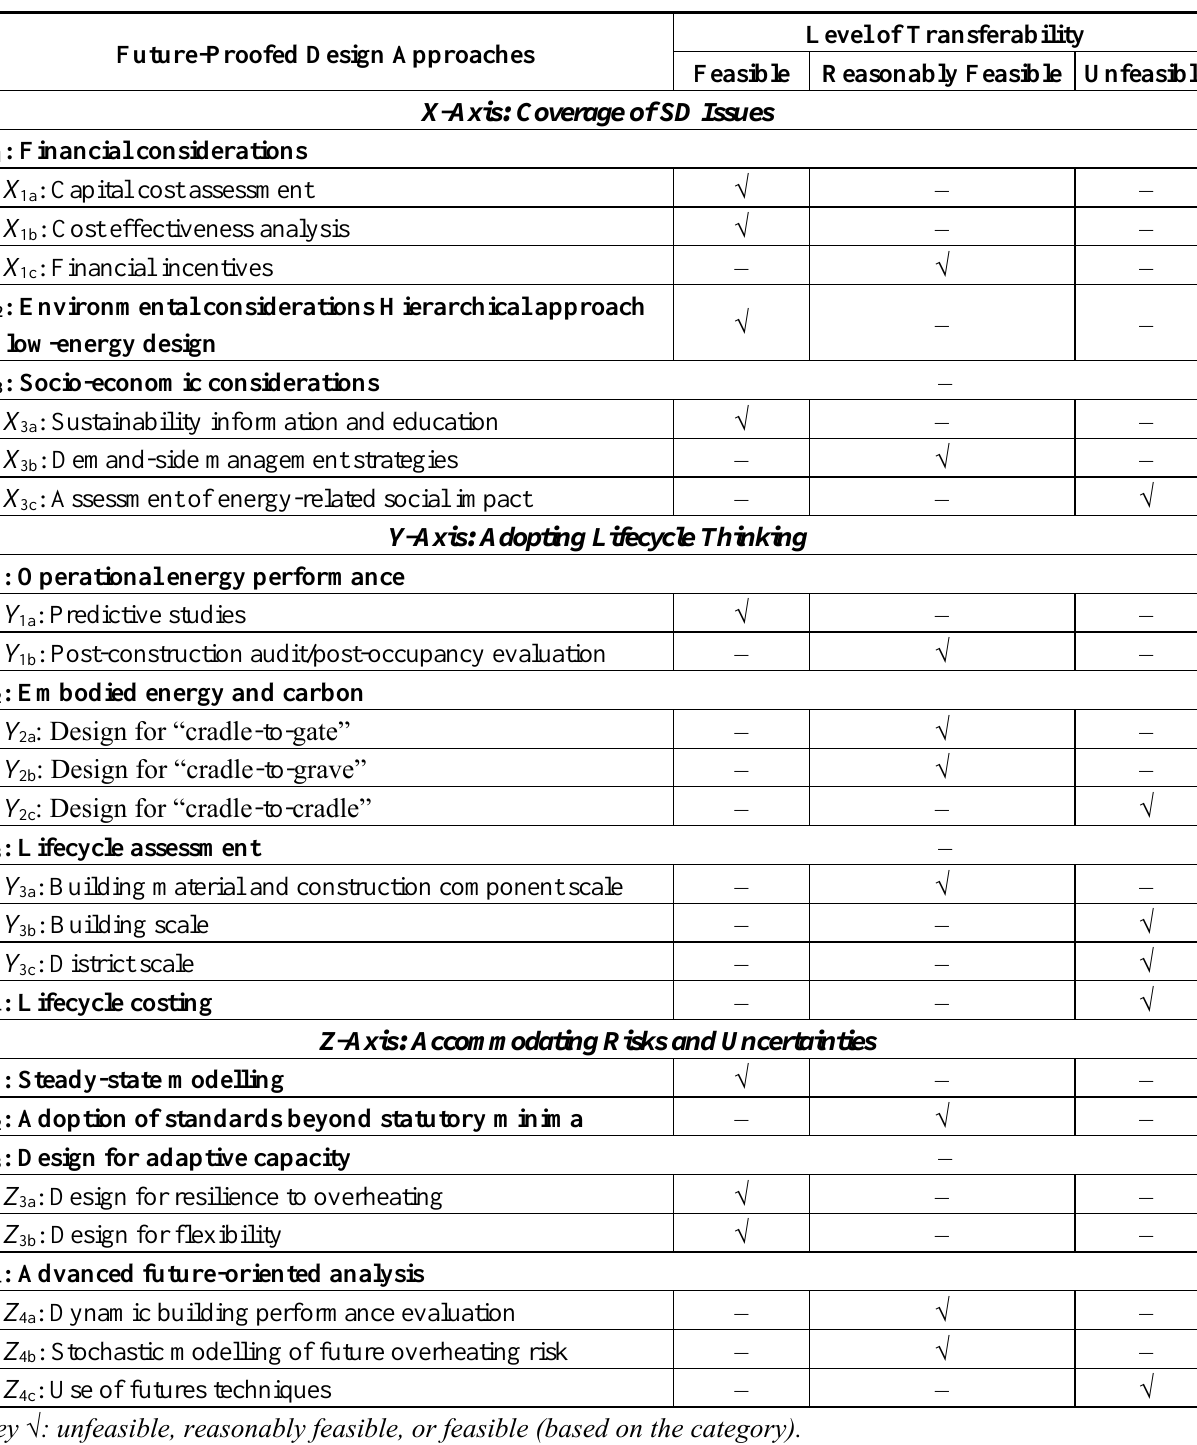
Table 5. Transferable design approaches for new housing developments in the UK. (From interview